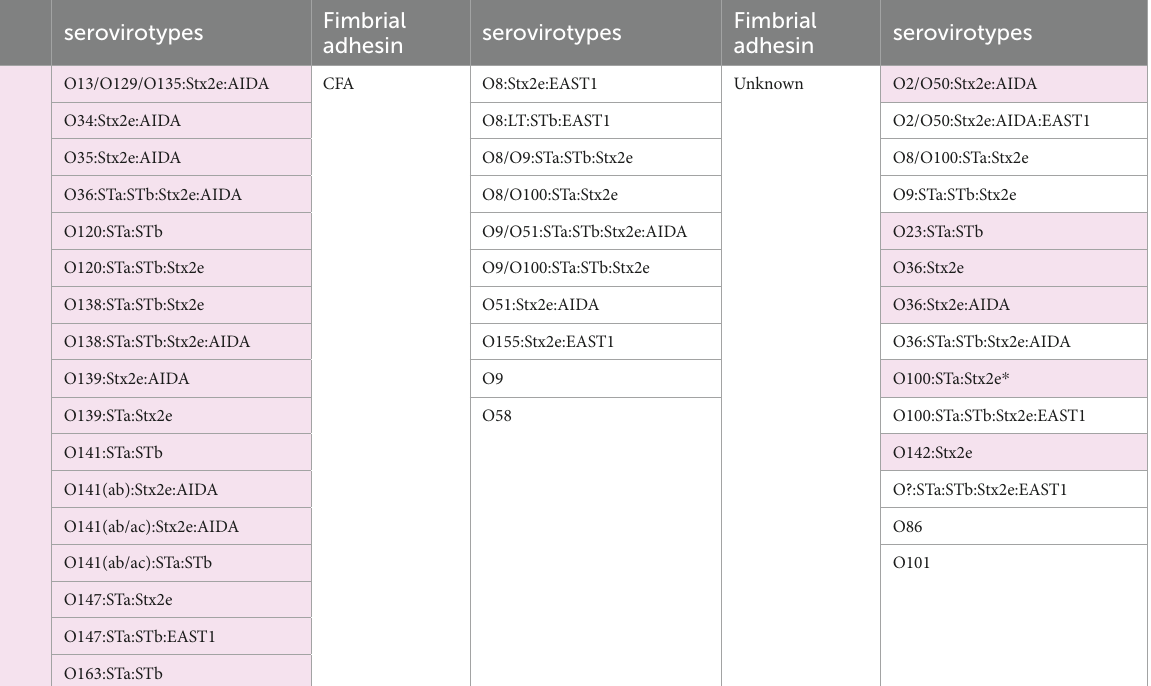
TABLE 1 Overview of the different obtained